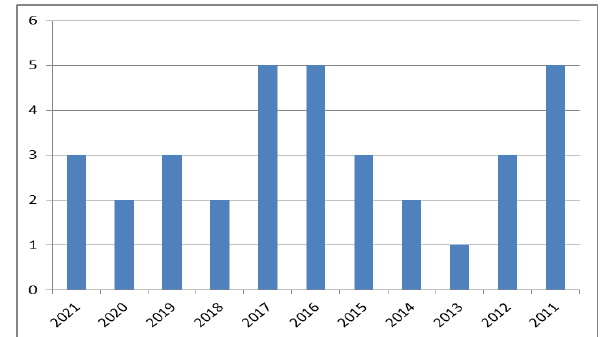
Figure 2 . Number of papers by